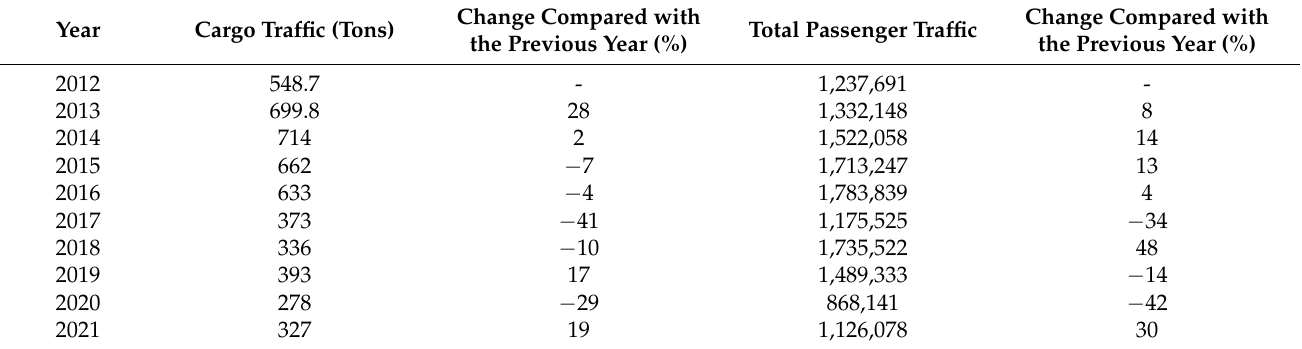
Table 6. Cargo and passenger traffic [45].